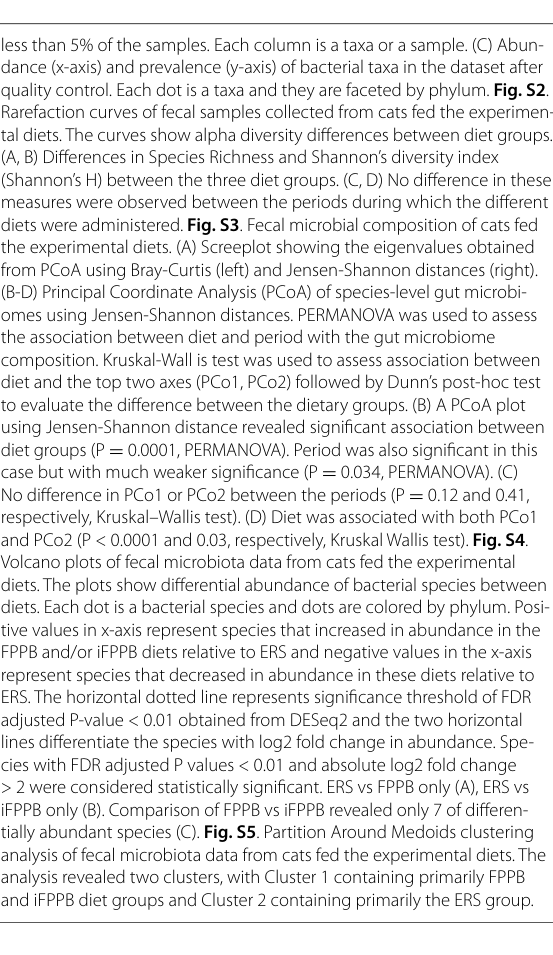
Additional file 1 : Table S1 . Ingredient and analyzed nutrient composi- tion of the experimental diets fed to cats. Table S2 . Body weight, BCS, and food intake of cats fed the experimental diets. Table S3 . TNF-α concentra- tions (ng/L) of cell culture supernatants from cats fed the experimental diets. Table S4 . Serum chemistry profiles of cats fed the experimental diets. Table S5 . Hematology of cats fed the experimental diets. Table S6 . Bacterial species that were greater in feces of cats fed FPPB or iFPPB than those fed ERS. Table S7 . Bacterial species that were lower in feces of cats fed FPPB or iFPPB than those fed ERS. Table S8 . Kyoto Encyclopedia of Genes and Genomes Orthology (KO) terms that were greater in cats fed ERS than those fed FPPB or iFPPB. Table S9 . Kyoto Encyclopedia of Genes and Genomes Orthology (KO) terms that were greater in cats fed FPPB or iFPPB than those fed